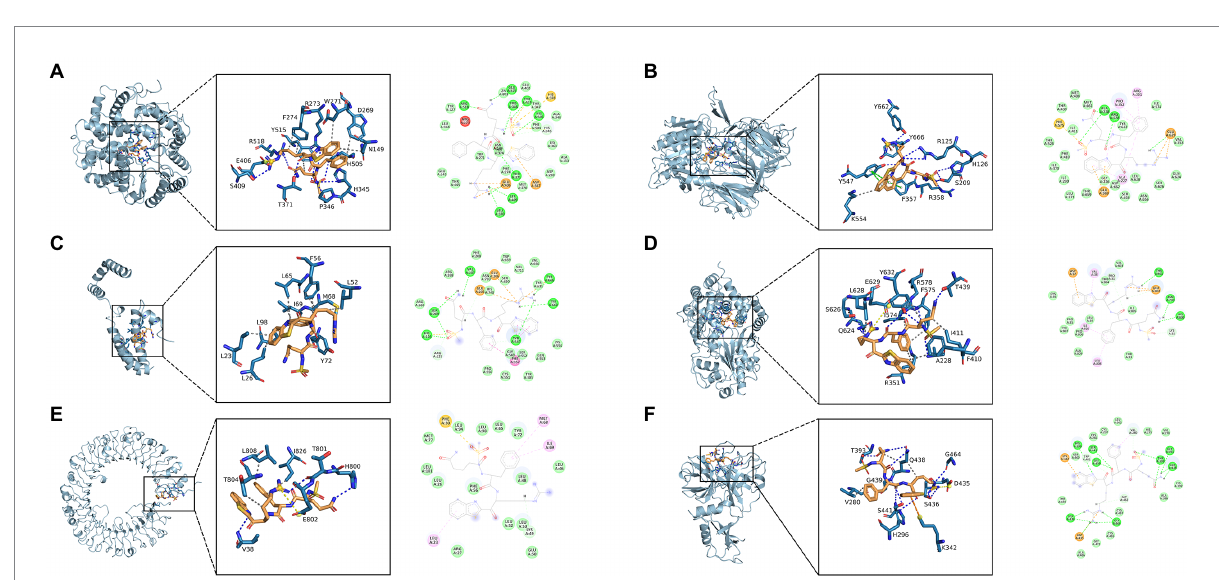
FIGURE 4 Molecular docking of small molecule N-0385 and protein targets. (A) N-0385/ACE2, (B) N-0385/DPP4, (C) N-0385/IL-10, (D) N-0385/NLRP3, (E) N-0385/TLR7, (F) N-0385/TMPRSS2.